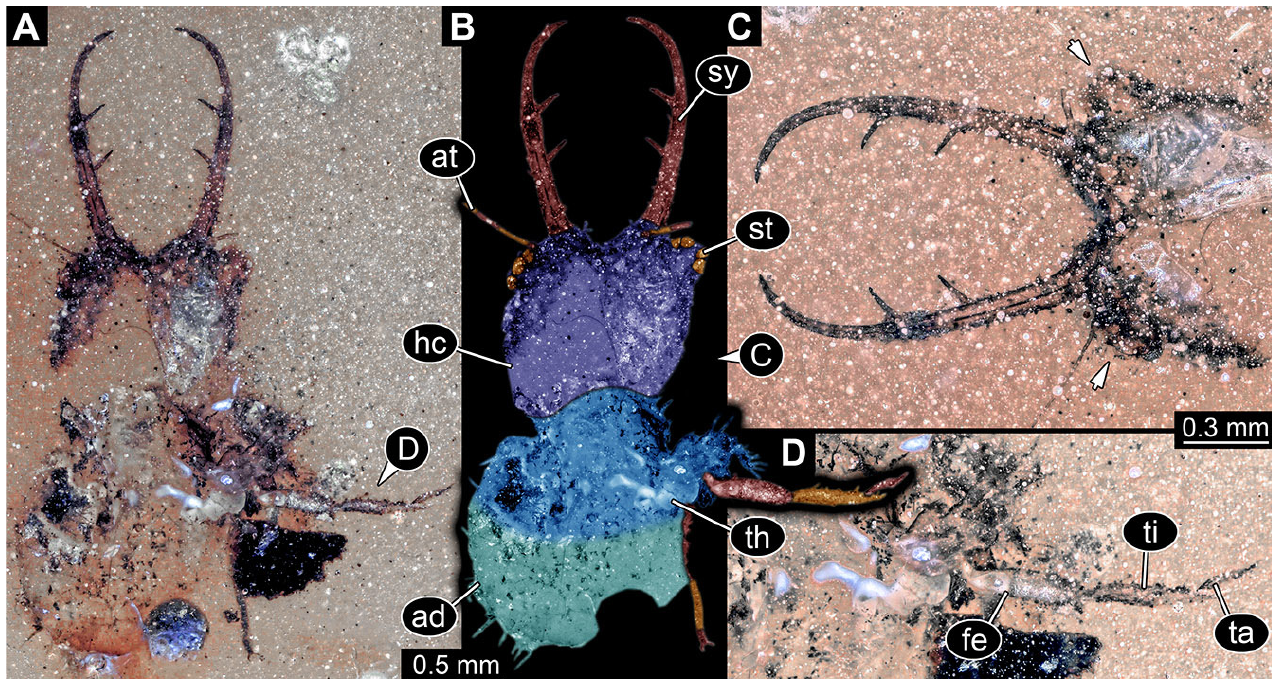
Figure 27. Fossil owllion larva, specimen 3240 (PED 0520), Cretaceous Kachin amber, Myanmar. ( A ) Overview, ventral. ( B ) Color-marked version of ( C ). ( C ) Overview, dorsal. ( D ) Close-up on field of stemmata (arrow). ( E ) Close-up on locomotory appendage with claws (arrows). ( F ) Close- up on dorsal process. Abbreviations: ad = abdomen; at = antenna; hc = head capsule; ms = meso- thorax; mt = metathorax; pt = prothorax; st = stemmata; sy = stylet.